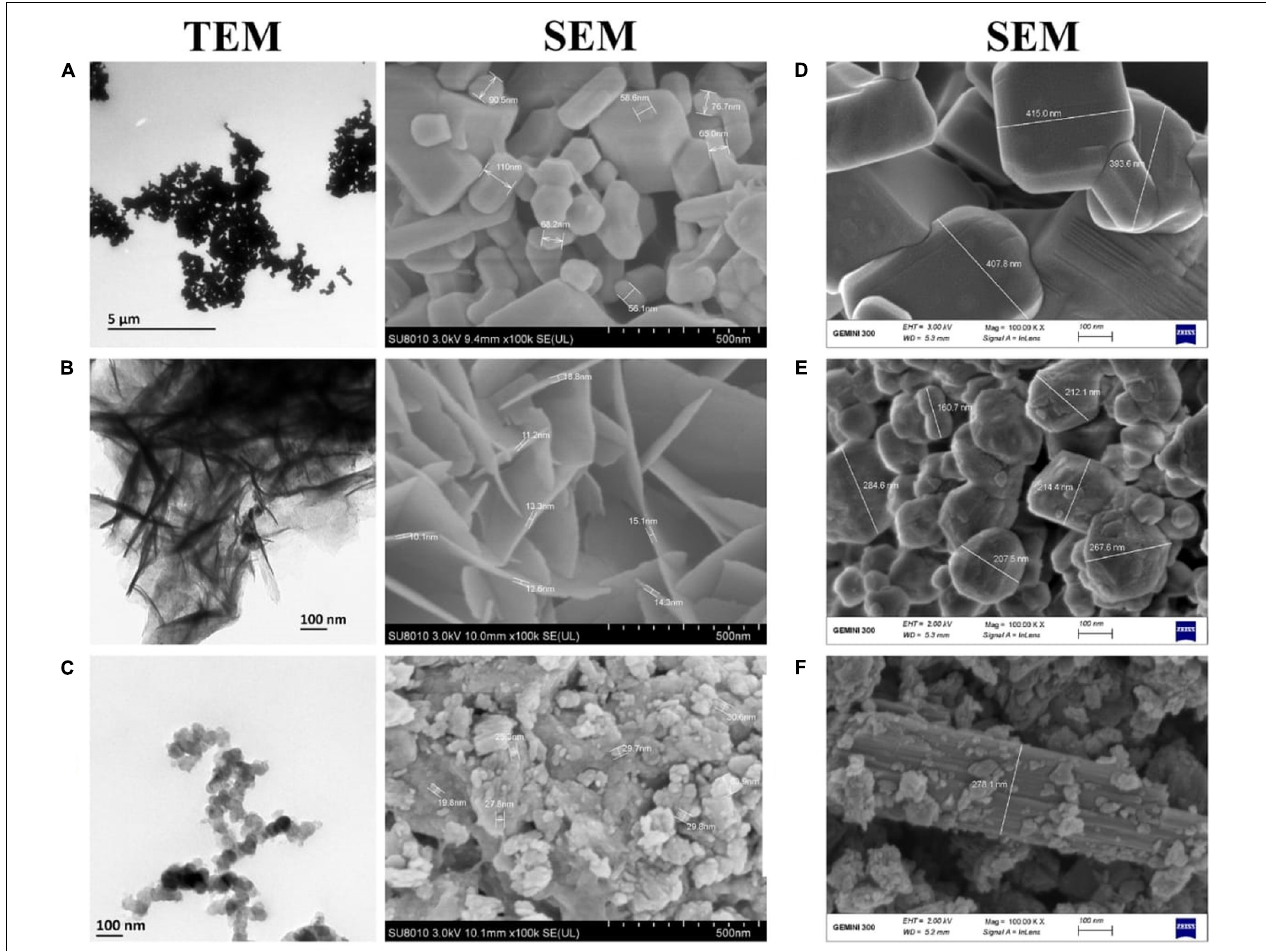
FIGURE 4 | Transmission and Scanning electron micrographs of (A) ZnO nanoparticles (B) MgO nanoparticles (C) MnO 2 nanoparticles and Scanning electron micrographs of Bulk metal oxides of (D) ZnO (E) MgO (F) MnO 2 . TEM Magnification 5,000X.